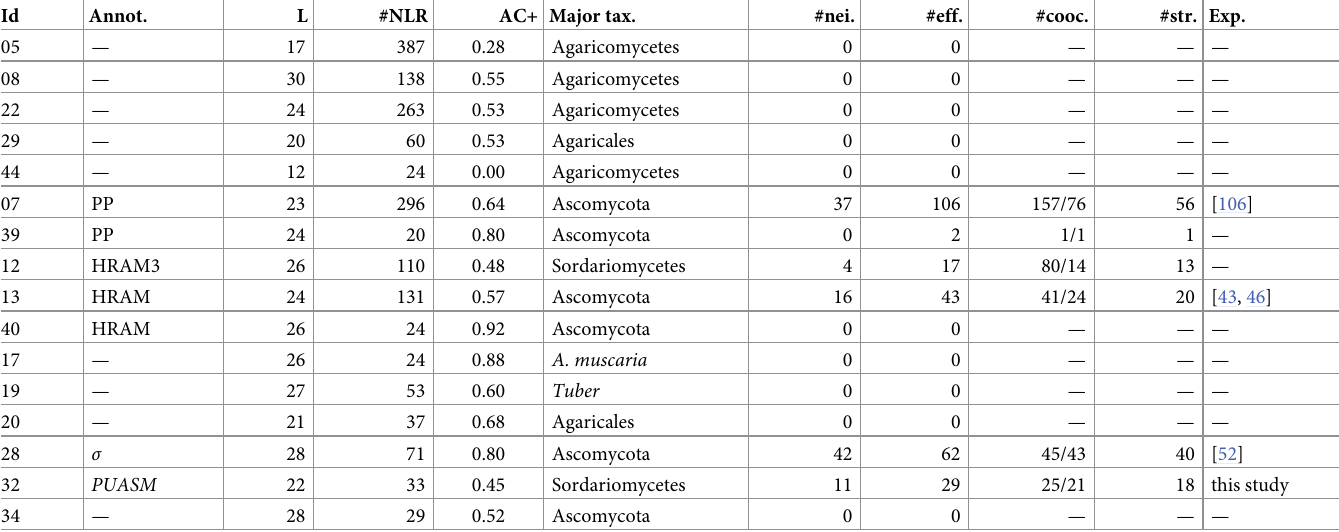
Table 1. Amyloid-like motifs in short N-termini of NLRs. Motif id indicates ranks in the MEME output. Motifs are grouped based on overlapping hits in NLRs and simi- lar sequence patterns. Established and proposed motif annotation labels are given where applicable. L is the motif length. #NLR and #nei. indicate number of sequences with a given motif in short N-termini of NLRs and C-termini of their genomic neighbors, respectively. AC+ indicates a proportion of motif instances for which ArchCandy score is 0.56 or above. Major taxonomic branch including vast majority of NLRs with the motif is given. #eff. indicates total number of effector proteins (with established association to NLRs) [5] with a given motif in C-termini. #cooc. indicates number of sequences with a given motif in short N-termini of NLRs / C-termini of effector pro- teins cooccurring in the same strains (genome assemblies). #str. is a number of such strains with cooccurrence. Exp. indicates selected studies reporting experimental vali- dation of some properties typical to ASM for a motif instance in a given family.